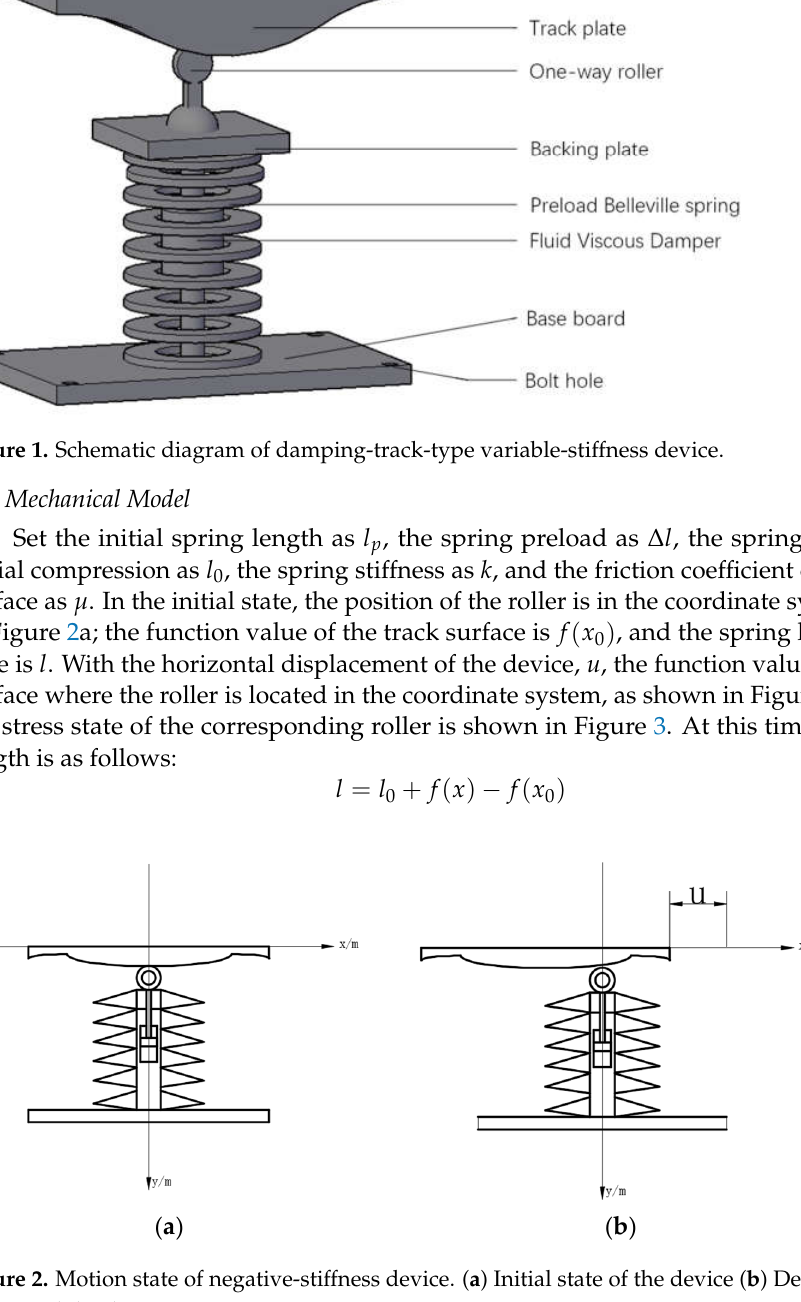
Figure 3. Stress-state analysis of roller. At this time, the friction force in the tangent direction of the track surface where the roller is located is as follows:  cos FF f 